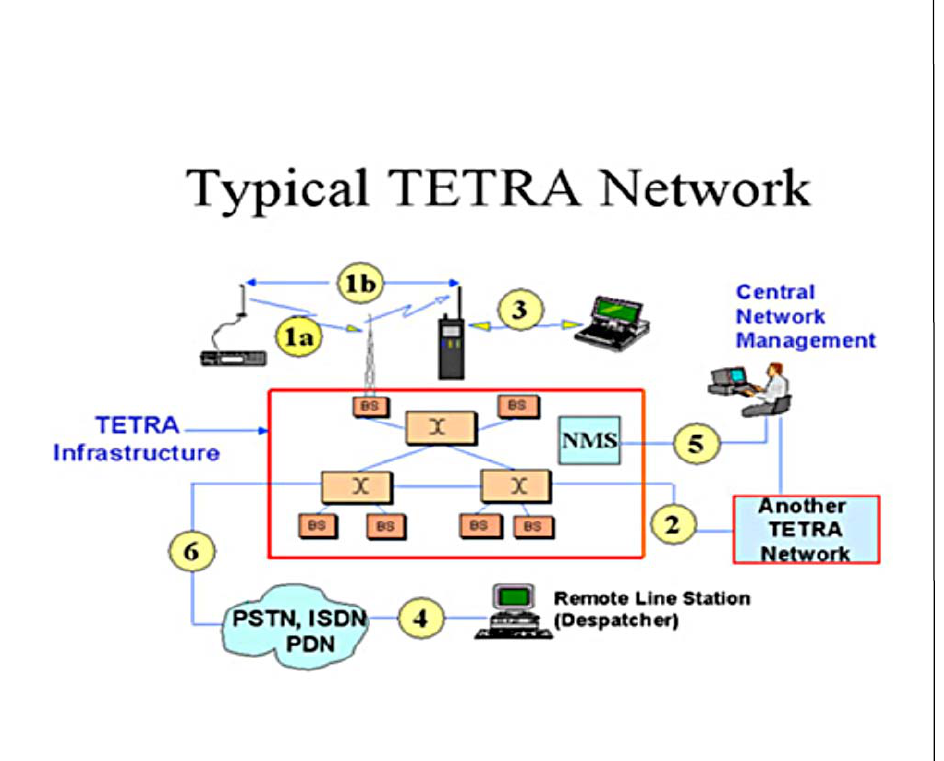
Figure 2 – Overview of different Interfaces in the TETRA standard (123seminarsonly, 2004) Рис . 2 – Обзор различных интерфейсов в рамках стандарта TETRA (123seminarsonly, 2004) Слика 2 – Приказ различитих интерфејса у стандарду TETRA (123seminarsonly,